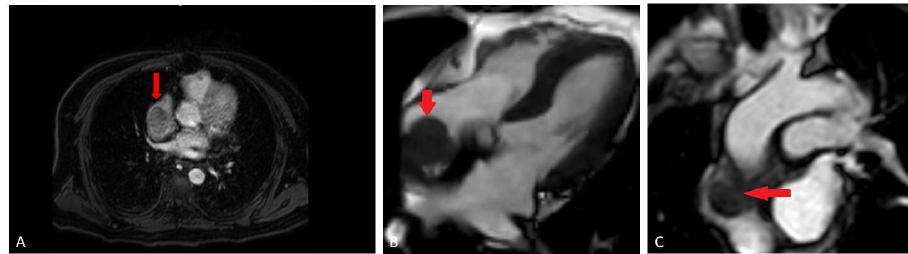
Figure 1. ( A ) Cardiac MRI early post-contrast mDixon sequence (fat suppressed gradient echo sequence), demonstrates enhancing component of the mass in the distal left Superior Vena Cava (SVC); ( B ) cardiac MRI pre-contrast balanced turbo field echo (BTFE) sequence, demonstrating adherent mass (red arrow) along the right atrial free wall; ( C ) cardiac MRI early post-contrast perfusion sequence (T1 weighted, gradient-echo), demonstrating relatively homogeneous enhancement of the mass (red arrow).